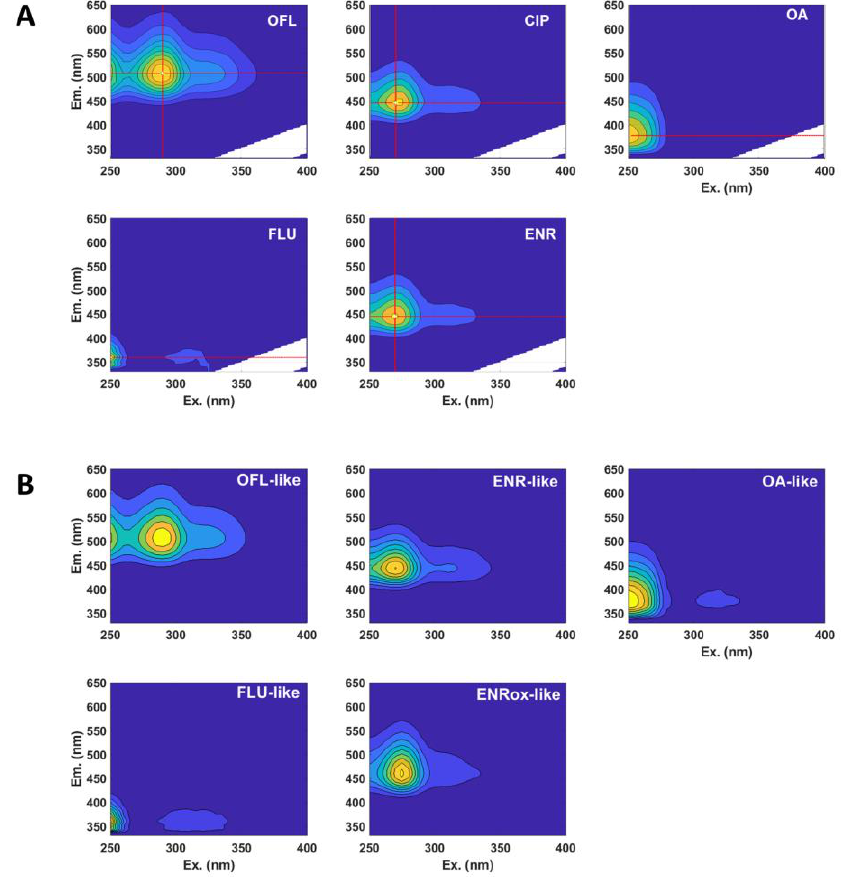
Figure 3. ( A ) Normalised fluorescence excitation-emission matrices (EEM) of (F)Qs standard solutions; ( B ) obtained PARAFAC model. The component ENR-like includes CIP fluorescence (due to its analogous fingerprint with ENR), and ENRox-like represents the fluorescence of a family of major transformation products coming from ENR and CIP photolysis.